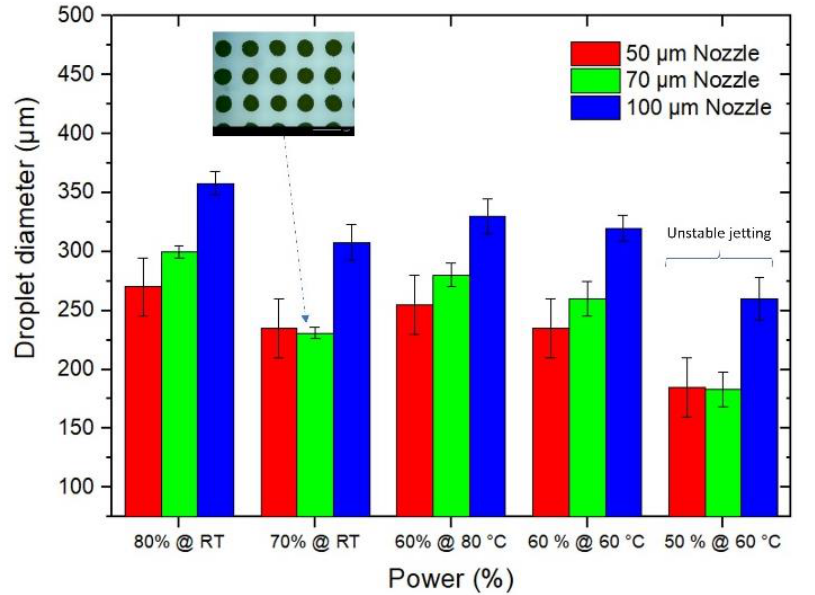
Figure 3. Droplet size analysis of the glass frit paste jetted with different nozzles, powers and tem- peratures.